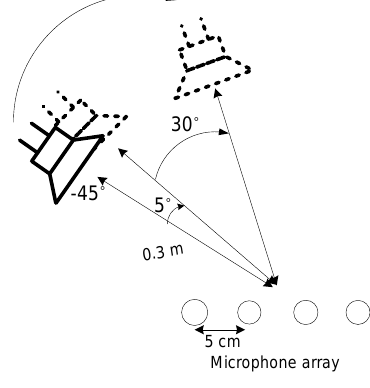
Figure 2. Experimental setting.